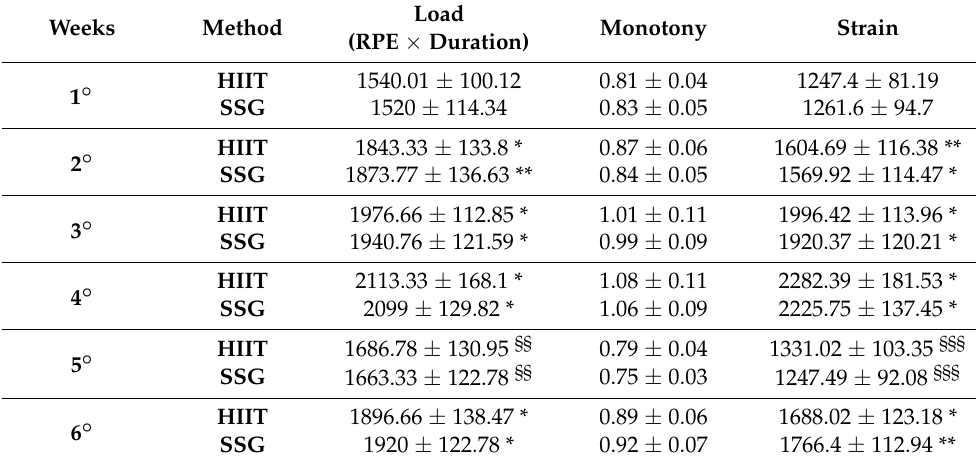
Table 3. Data Training Load, Training Monotony, and Training strain during six weeks of high intensity interval (HIIT) or small-sided games (SSG)